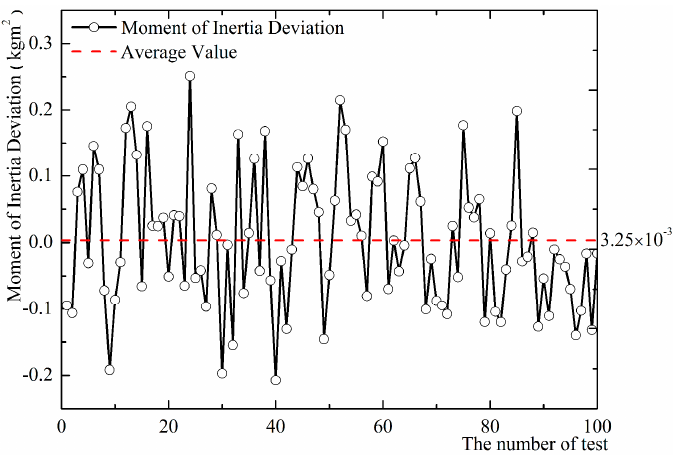
Figure 9. The moment of inertia difference of the workpiece. Table 10. Standard workpiece rotation inertia test data.